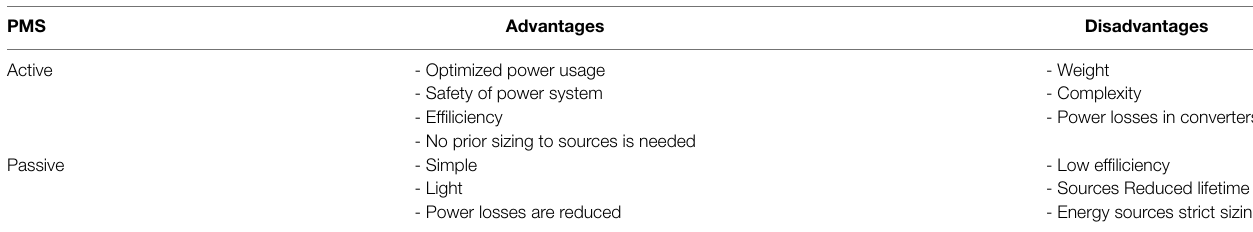
TABLE 5 | Comparison: passive and active power management